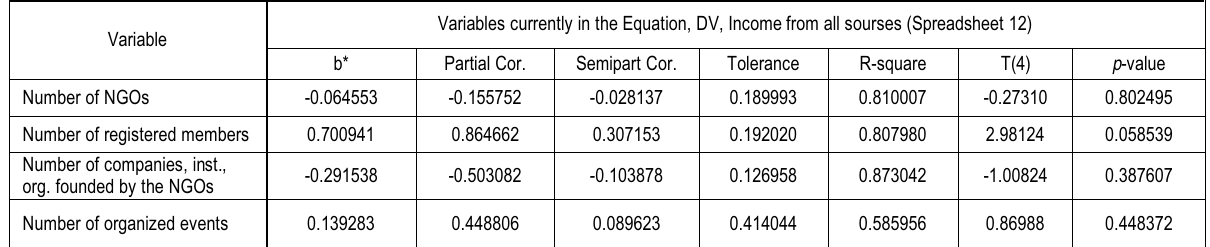
Table 9. The results of correlation and regression analysis in the Statistica system